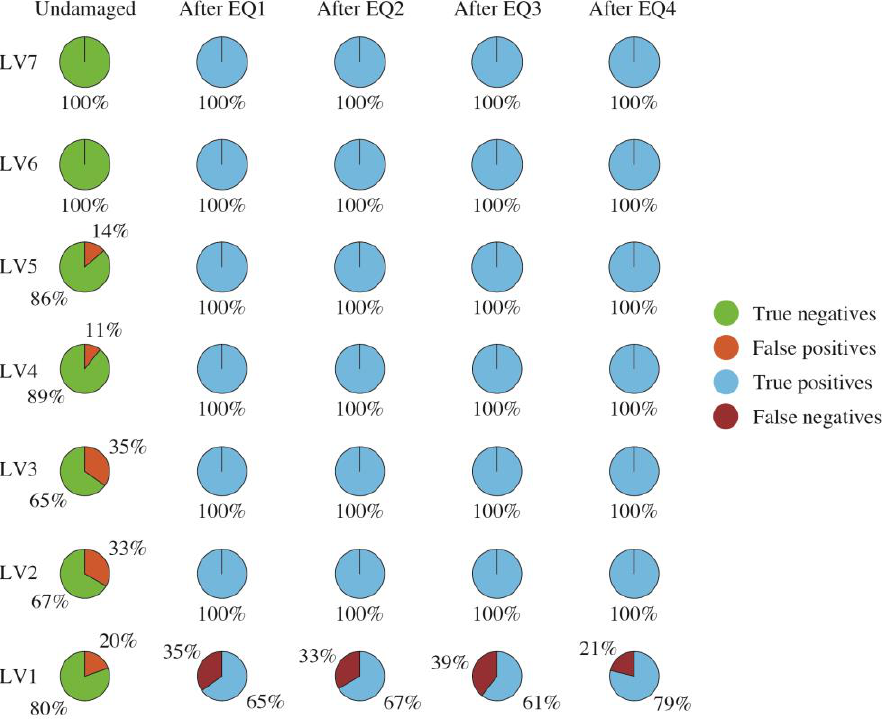
Figure 9. Accuracy of damage detection for each scenario.